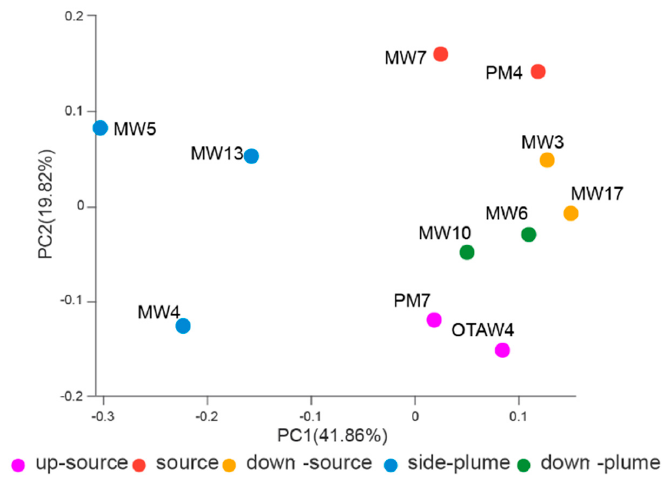
Figure 4. The PCoA plot of samples at the genus level.